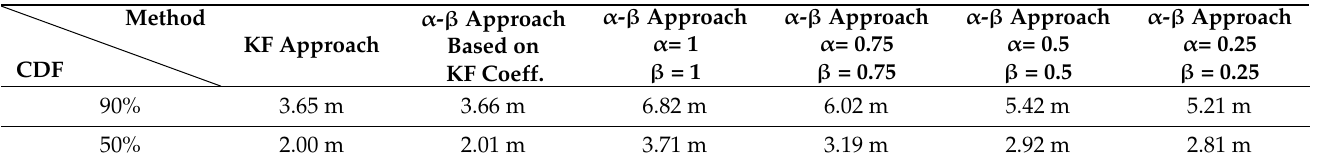
Figure 11. Cumulative distribution function of the error distances, KF software- based, α - β software - based, KF VLSI- based, and proposed approach with α - β chip -based tracking approaches. Table 7. The Cumulative distribution function of the error distances, KF software-based, α - β software- based, KF VLSI-based, and proposed approach with α - β chip-based tracking approaches.